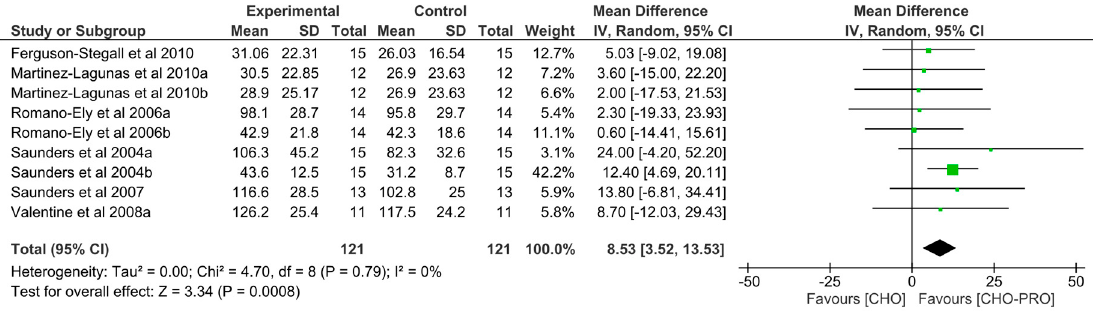
Figure 4. Effect of CHO-PRO intake during exercise on TTE performance compared to CHO. CI: confidence interval; MD: mean difference.